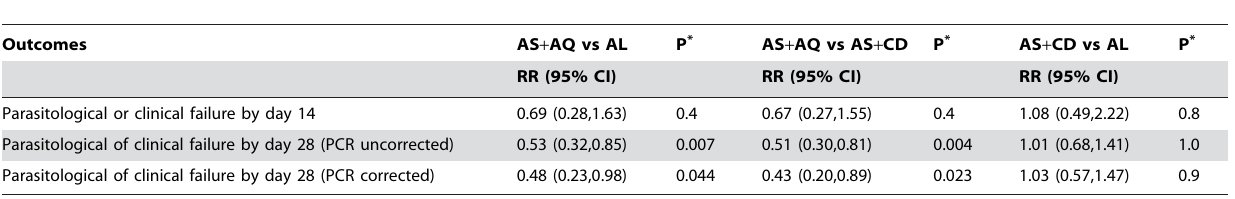
Table 3. Comparison of treatment outcomes between groups (per protocol analysis).